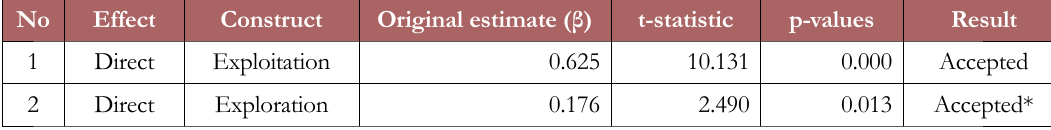
Table 7. Hypothesis test result for exploration and exploitation to CIC in manufacturing